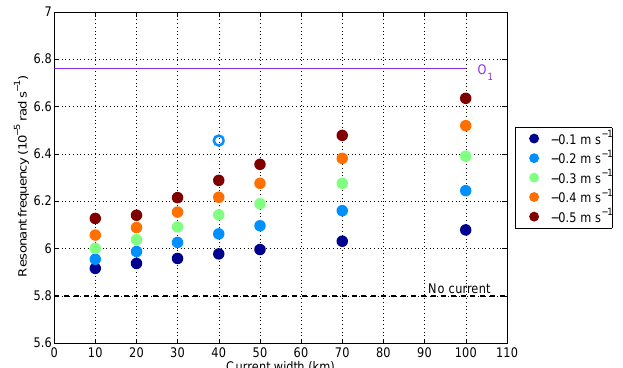
Figure 11. Sensitivity test for changing the width and strength of the slope current. Additionally, an example for the RF of a less barotropic (i.e. surface-enhanced) current is shown by the open blue marker. The RF for the reference stratification without added cur- rent (see Fig. 9) is indicated by a broken black line, and the tidal frequency O 1 is marked by a solid purple